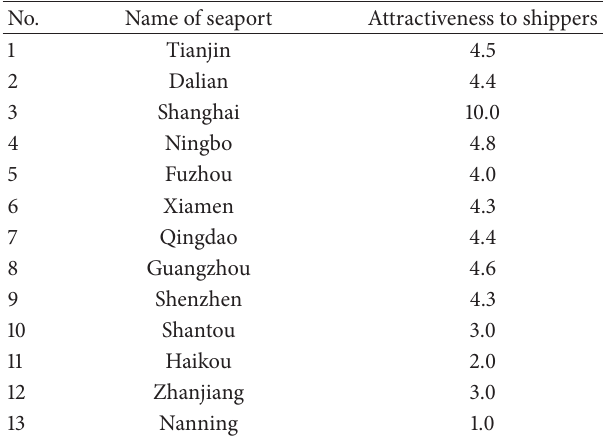
Table 1: Seaports and their attractiveness to